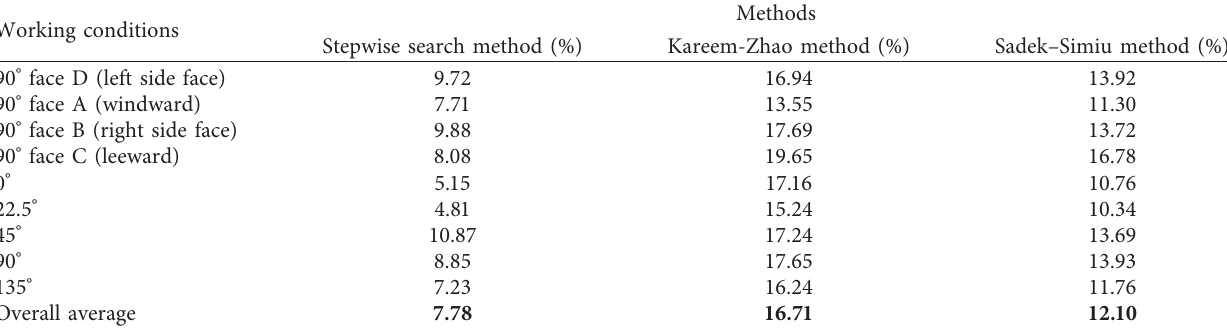
Table 3: Average error rates of the peak factor calculated by different methods under different working conditions. Working